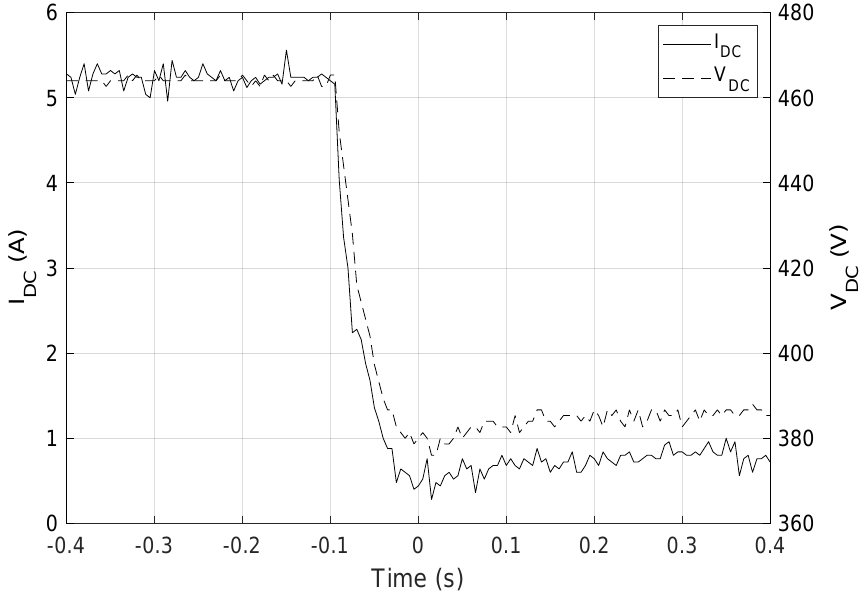
Figure 9. Experimental results: current set-point changed from 5 A to 0.5 A